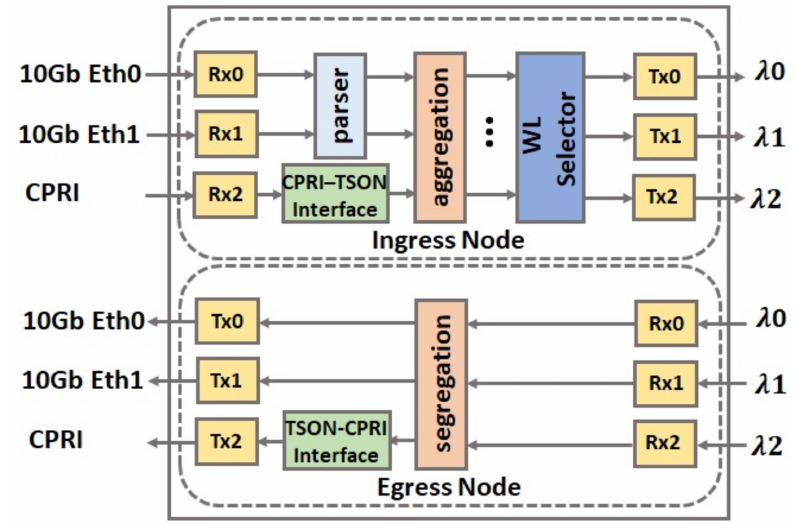
Figure 5. TSON edge node multi-protocol data plane architecture. Rx: receiver, Tx: transmitter, WL: wavelength, CPRI: common public radio interface, TSON: time shared optical